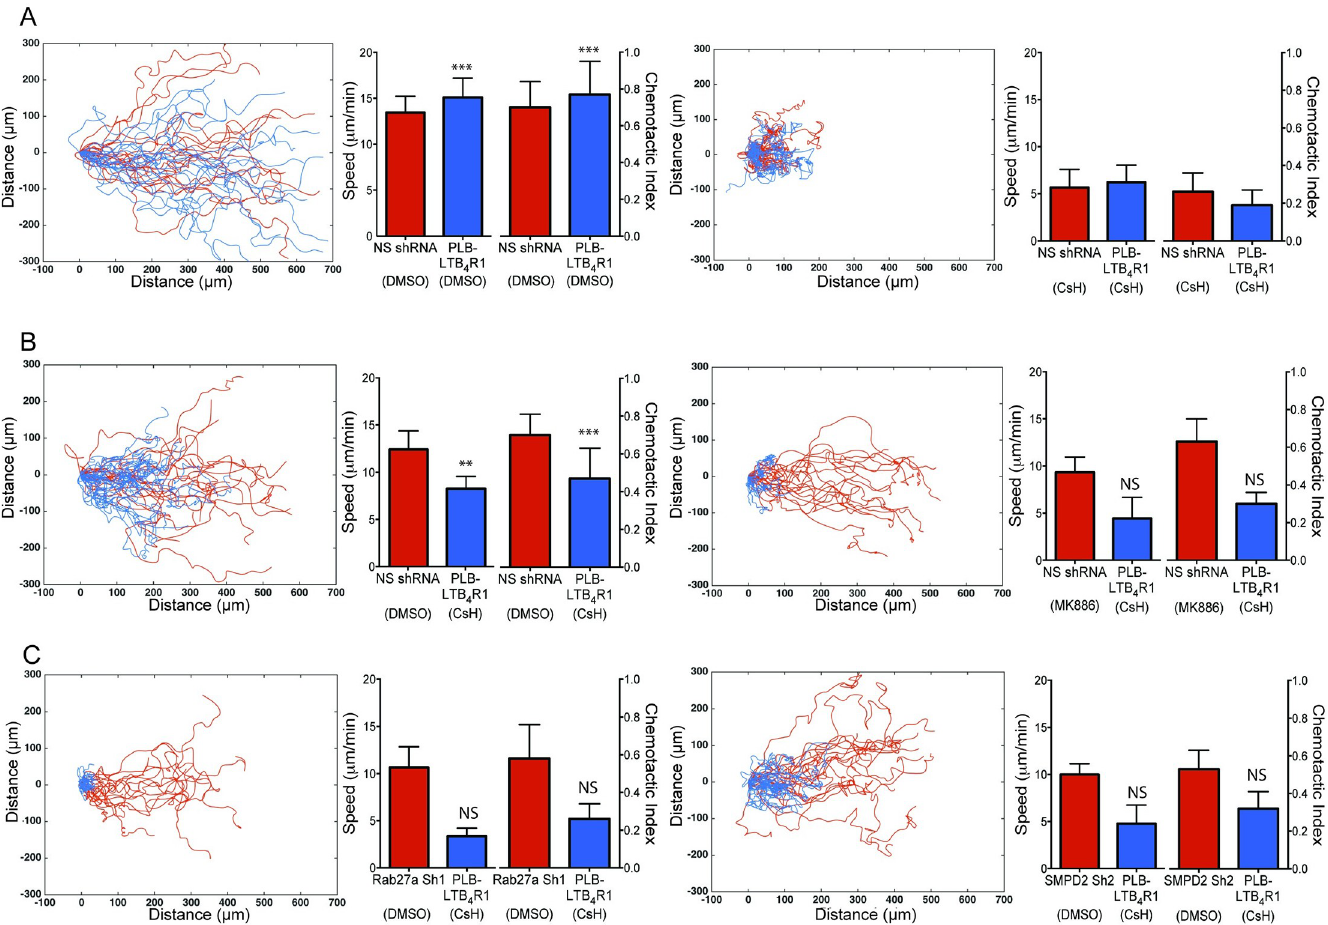
Fig 6. Exosomes mediate signal relay during neutrophil chemotaxis. Tracks, speed, and CI of mixtures of cytotracker-labeled cell lines migrating under agarose towards an approximately 50 pM/ μ m gradient of fMLP. Also see S7 Fig and S12 Movie. (A) Differentiated cells overexpressing the LTB 4 R1 (labeled with cytotracker green, shown as blue tracks) in a mixture with NSshRNA cells (labeled with cytotracker red, shown as red tracks) treated with DMSO (left) or CsH (right). Composite graph shows displacement tracks of both types of cells. Speed and CI were calculated from the tracks of 40 cells and averaging over 8 independent movies . (B) Differentiated cells overexpressing the LTB 4 R1 (labeled with cytotracker green, shown as blue tracks) treated with CsH in a mixture with NSshRNA cells (labeled with cytotracker red, shown as red tracks) treated with DMSO (left) or MK866 (right). Composite graph shows displacement tracks of both types of cells. Speed and CI were calculated from the tracks of 40 cells and averaging over 4 independent movies . (C) Differentiated cells overexpressing the LTB 4 R1 (labeled with cytotracker green, shown as blue tracks) in a mixture with Rab27a sh1 (labeled with cytotracker red, shown as red tracks) or SMPD2 sh2 (right) cells treated with DMSO. Composite graph shows displacement tracks of both types of cells. Speed and CI were calculated from the tracks of 40 cells and averaging over 4 independent movies. The symbols ��� , �� , � , and NS indicate p < 0.0001, p < 0.001, p < 0.01, and p > 0.05, respectively, compared to CsH-treated PLB-LTB 4 R1 cells. Raw data for panels A–C can be found in the Supporting information section S1 Data file. CI, chemotaxis index; CsH, cyclosporin H; fMLP, N-formylMethionyl-Leucyl-Phenylalanine; LTB 4 R1, receptor for LTB 4 ; NS, not significant; NSshRNA, nonspecific